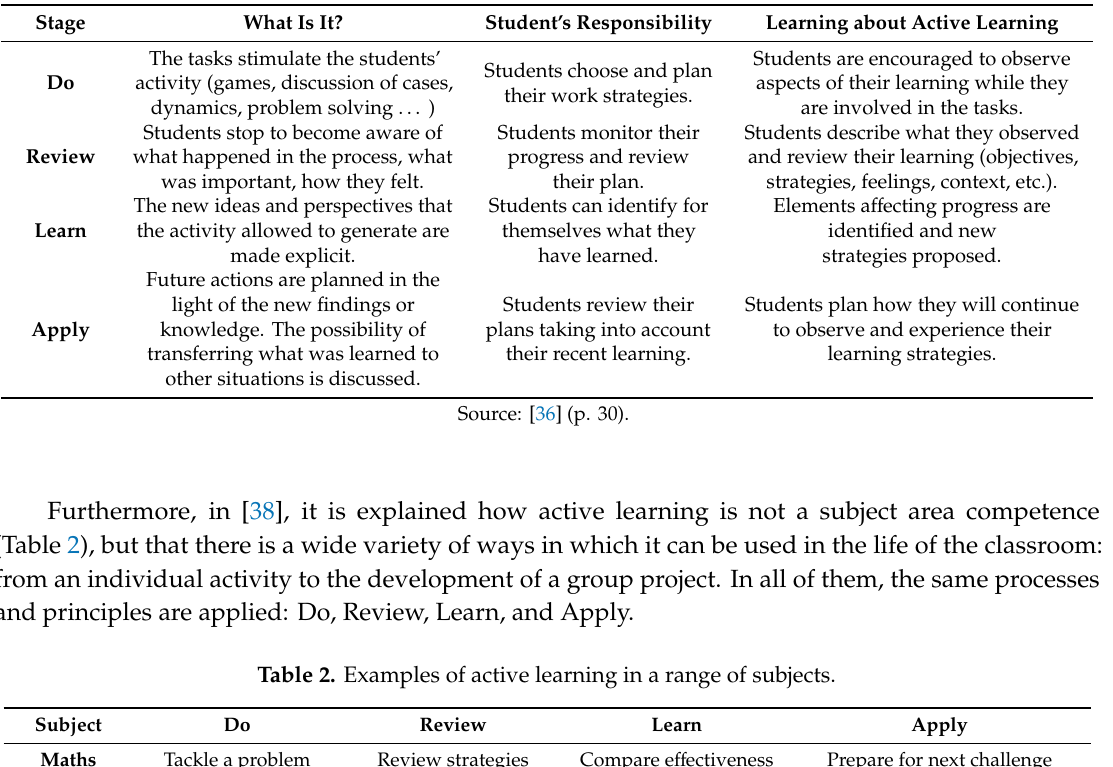
Table 1. Stages of active learning.